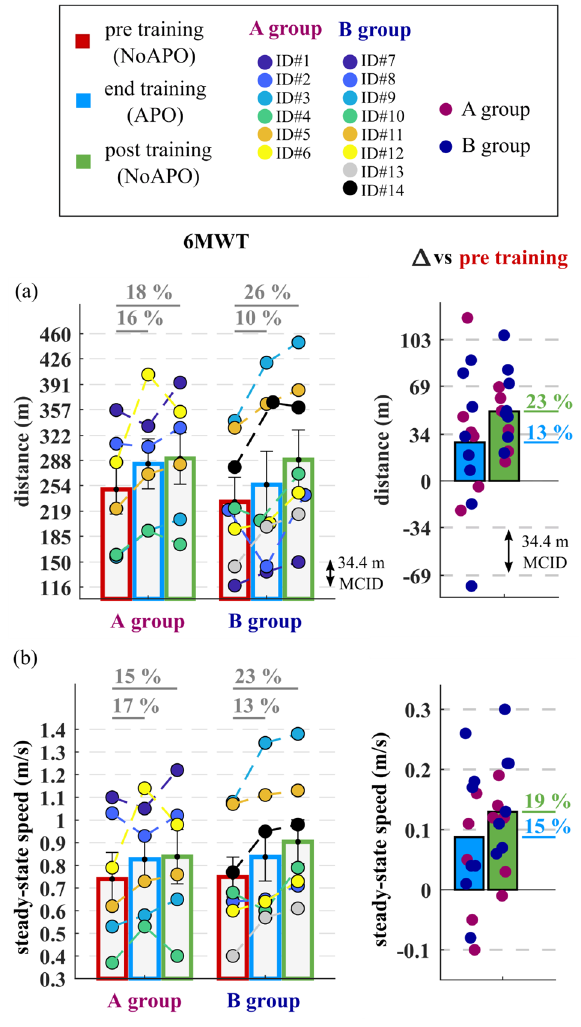
Figure 3. Results of the 6MWTs pre and post-training. ( a ) Walked distance and ( b ) steady-state speed during 6MWTs. Data are reported for each study group in bar plots as means and standard errors (left) and as differences between pre-training (NoAPO) and training (APO) and post-training (NoAPO) (right). The minimal clinically important difference (MCID) for the distance is depicted in each plot with dashed horizontal lines. Circles represent individual study